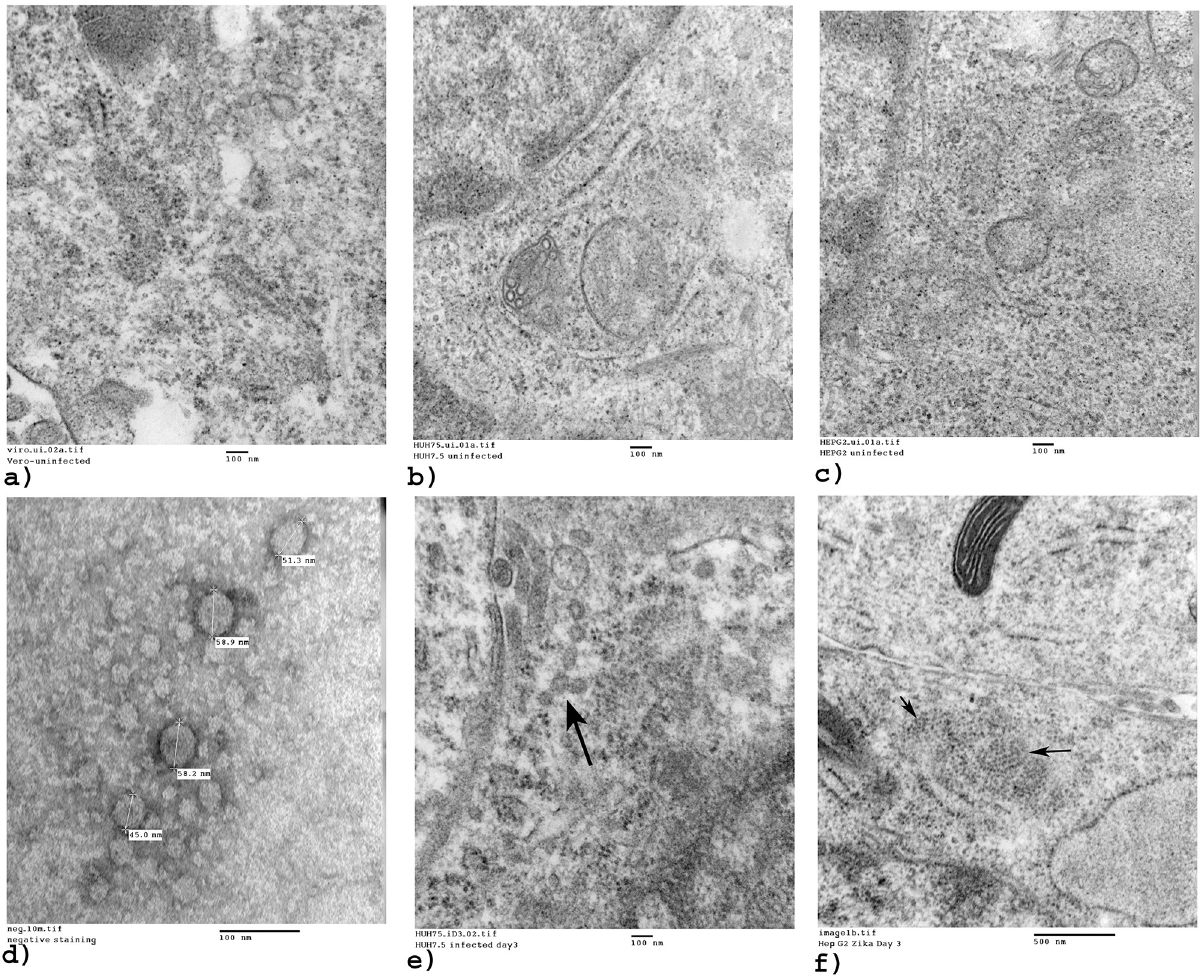
Fig 5. TEM images. Cell lines with either uninfected or Zika-infected cells were visualized by electron microscopy to observe ultrastructure, after three days of infection. Black arrows point to ZIKV. a) EM image of uninfected Vero cells. Magnification = 80000x. Scale bar = 100 nm. b) Uninfected Huh7.5 cells. Magnification = 80000x. Scale bar = 100 nm. c) Uninfected HepG2 cells. Magnification = 80000x. Scale bar = 100 nm. d) EM image using negative staining of Zika virions in Vero cell culture supernatant. Particle sizes in nm. Magnification = 300000x. Scale bar = 100 nm. e) EM image of Zika infection in Huh7.5 cells. Magnification = 80000x. Scale bar = 100 nm. f) EM image of HepG2 cells infected with Zika virus. Magnification = 60000x. Scale bar = 100 nm.